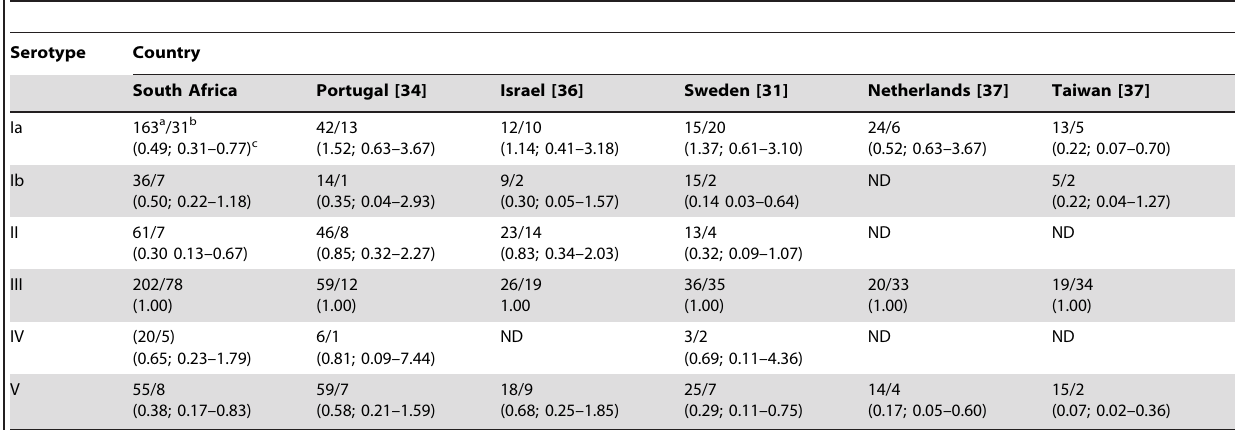
Table 3. Estimation of invasive potential of Group B streptococcus (GBS) serotypes in different countries.